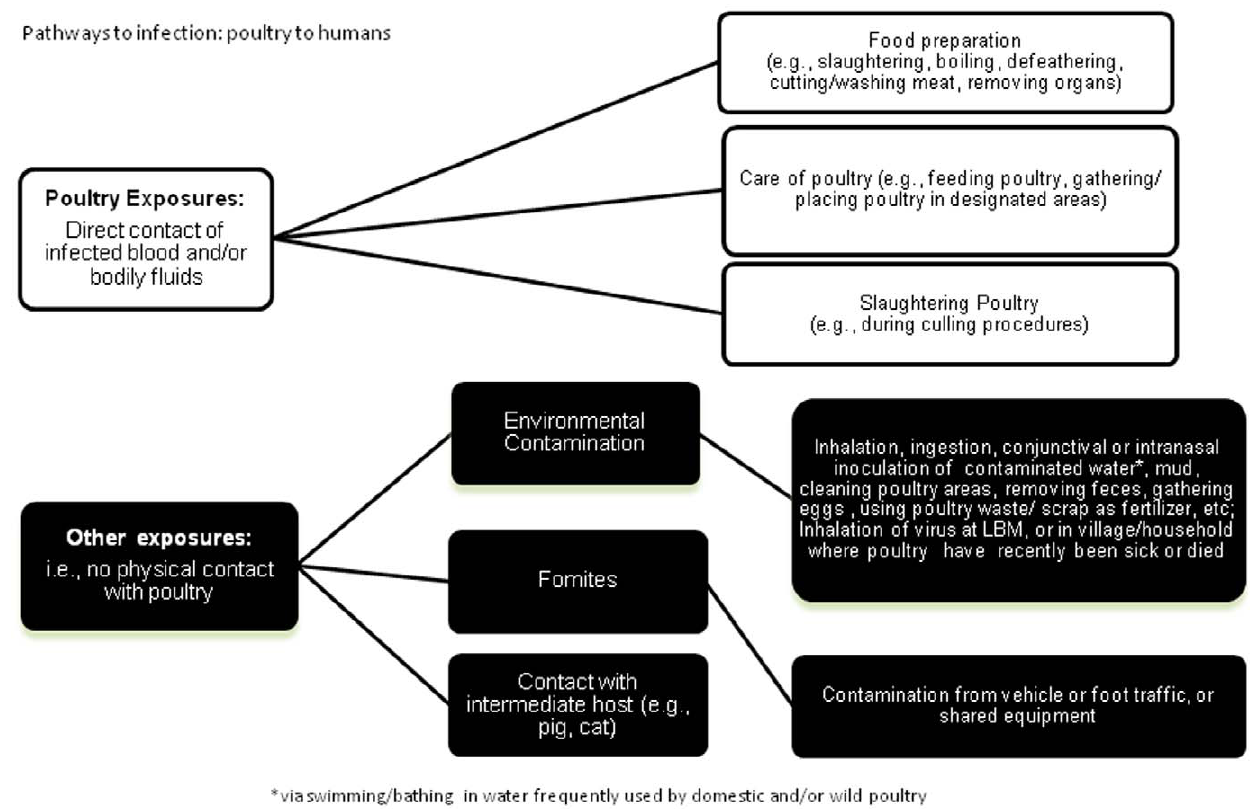
Figure 1. Known and suggested pathways of H5N1 exposure to infection from poultry to humans. *via swimming/bathing in water frequently used by domestic and/or wild poultry.